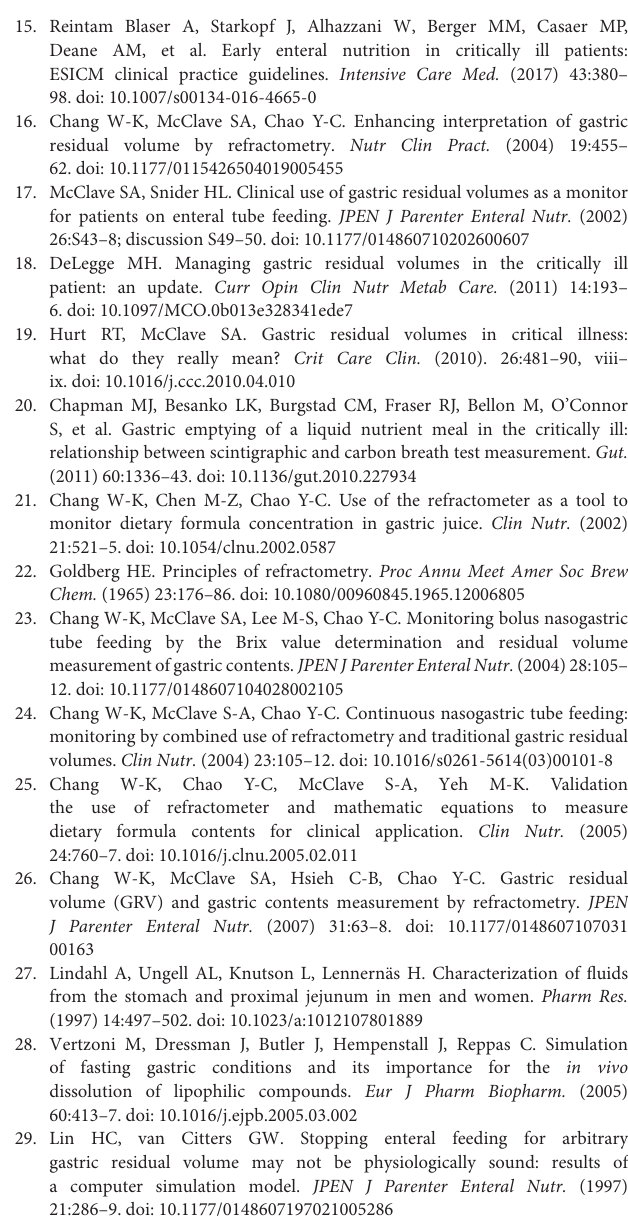
Supplementary Figure 1 | Theoretical overestimation of NF-volume in mixtures of 50ml NF with 50ml of water and a variable amount of endogenous gastric secrete (“gastric juice”) with a variable refractive index (BV). The presence of gastric secretions with a BV higher than 0 leads to an overestimation of the volume of NF present within the investigated gastric volume. The amount of overestimation is shown as a function of the BV of gastric secretions and of the amount of gastric juice present within the stomach for a standard measurement which is done by applying 50ml of water to a GRV in which 50ml of NF are truly